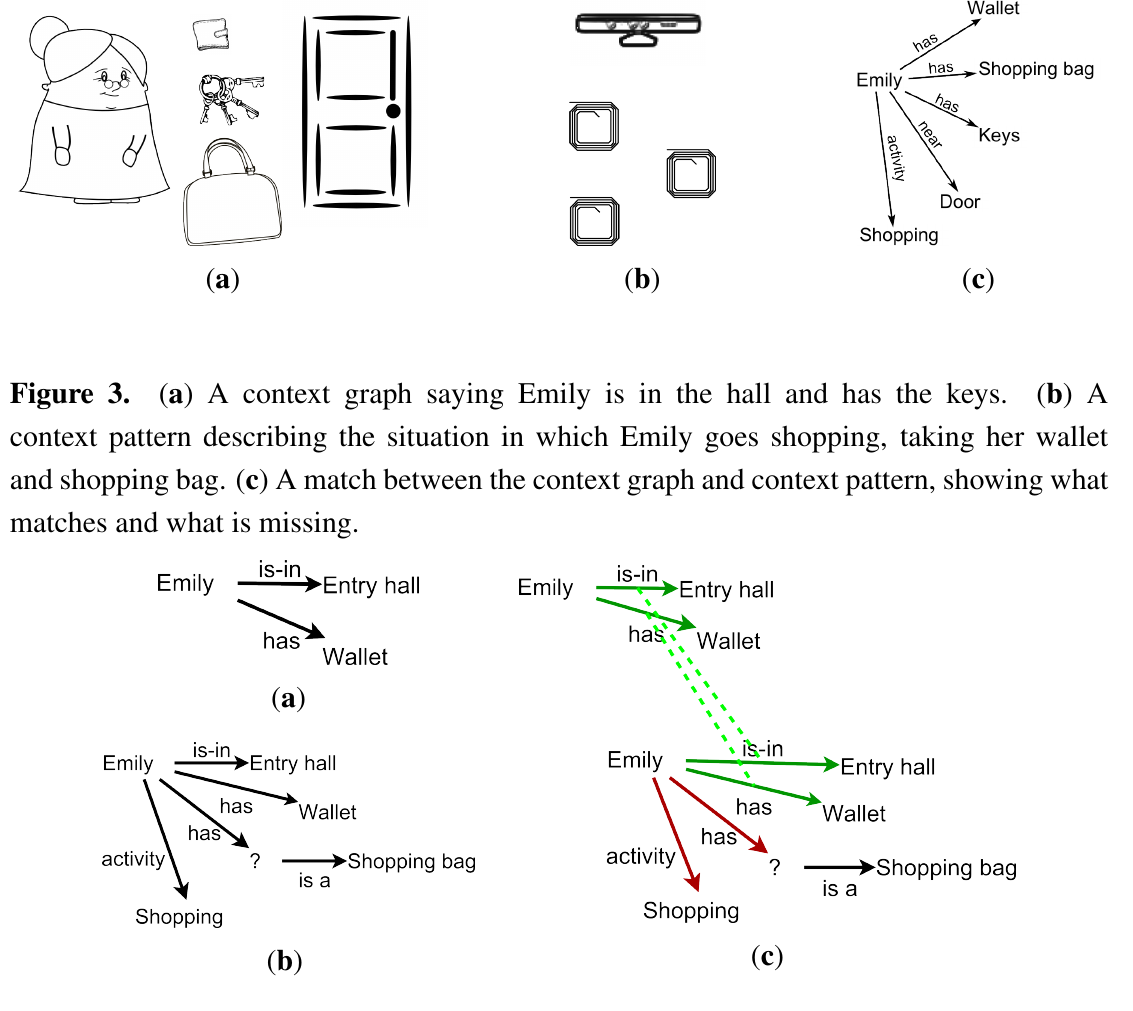
Figure 2. ( a ) Scenario: Emily is near the door, having her wallet, her keys and her shopping bag with her. ( b ) The Kinect sensor detects Emily near the door. The RFID detector near the door detects the tags placed on her wallet, keys and bag. ( c ) The pattern used by the system to detect, based on the given information, that Emily will go shopping. Clip art from http://clker.com under a Creative Commons Zero (CC0) License.